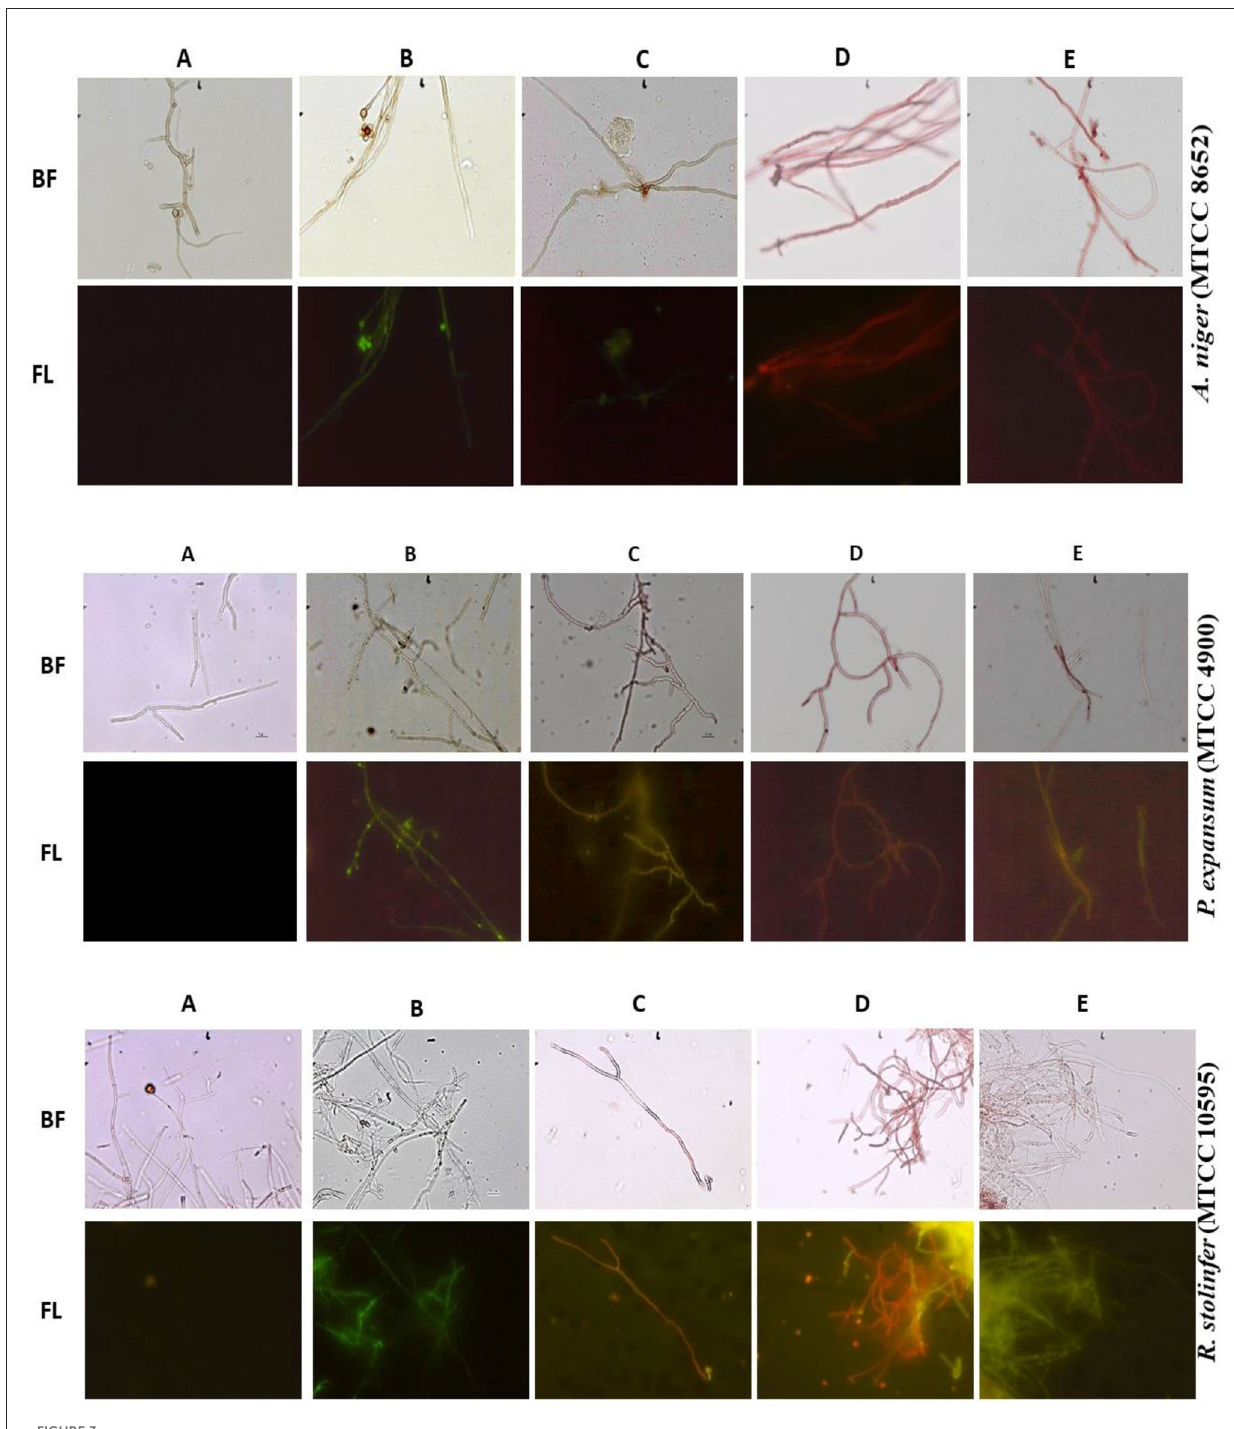
FIGURE3 A. niger MTCC 8652, P. expansum MTCC 4900, and R. stolinifer MTCC 10595 mycelia were exposed to M. purpureus pigment extracts extracts [hexane (C) , ethyl acetate (D) , and ethanol (E) ] and amphotericin (B) for 6h. The untreated mycelia grown in RMPI served as control (A) . The treated and untreated mycelia were subsequently stained with DiBAC viability stain and observed with bright field (BF) and fluorescent (FL) microscopy at 400 magnification. The mycelia treated with amphotericin-B and pigment extract have shown enhanced green fluorescence indicating fungicidal